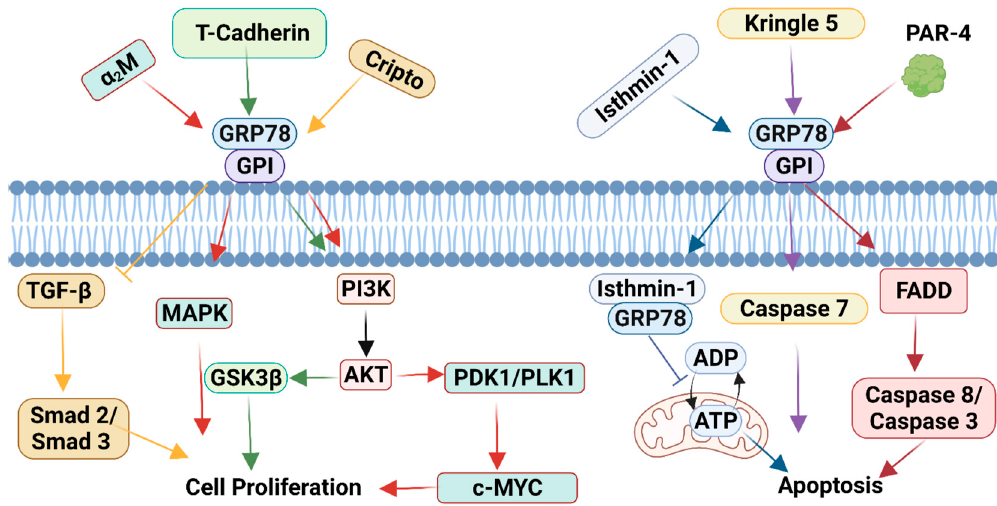
Figure 3. csGRP78 functions as a signaling receptor that mediates cell proliferation or apoptosis. At the cell surface, GRP78 associates with GPI-anchored proteins. Activated α 2 M binds to csGRP78 and activates the PI3K/AKT pathway, which stimulates the PDK1/PLK1 pathway to upregulate c-MYC expression and cell proliferation (red arrows). Similarly, T-cadherin interacts with GRP78 to activate the PI3K/AKT pathway and stimulates GSK3 β to increase cell proliferation (green arrows). Further- more, Cripto binds to csGRP78 and inhibits TGF- β -mediated Smad2/3 activation and results in cell proliferation (yellow arrows). Cell surface GRP78 can also induce apoptosis through isthmin-1 in- teracting with csGRP78 to allow for GRP78 internalization. This leads to the inhibition of mitochon- drial ATP transport and apoptosis (blue arrows). Furthermore, Kringle 5 interacts with csGRP78, which enhances caspase 7 activity (purple arrows). Moreover, Par-4 binds to GRP78 and activates the FADD-induced caspase 8/caspase 3 pathway to lead to apoptosis (maroon arrows). Image gen- erated with BioRender.